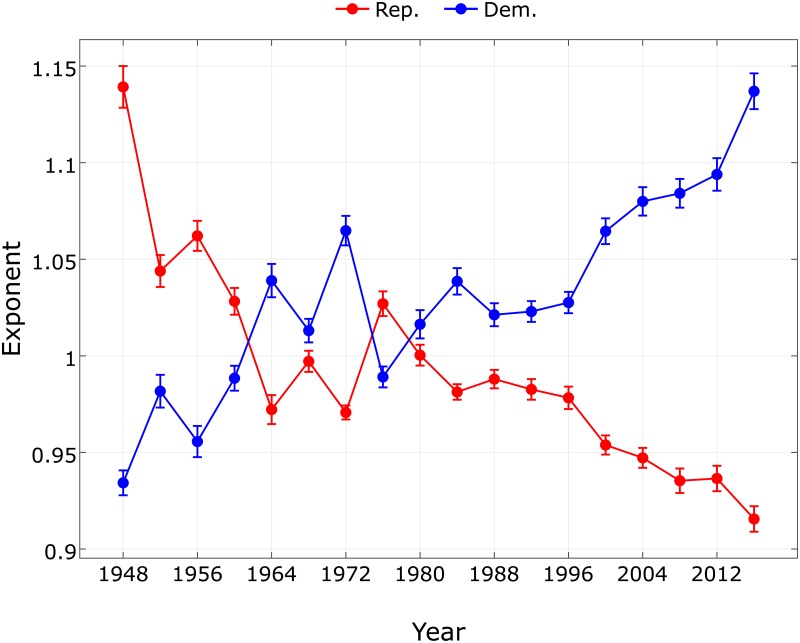
Scaling exponents for the Republicans (red) and Democrats (blue) with error bars for the 18 presidential elections of the US from 1948 to 2016.